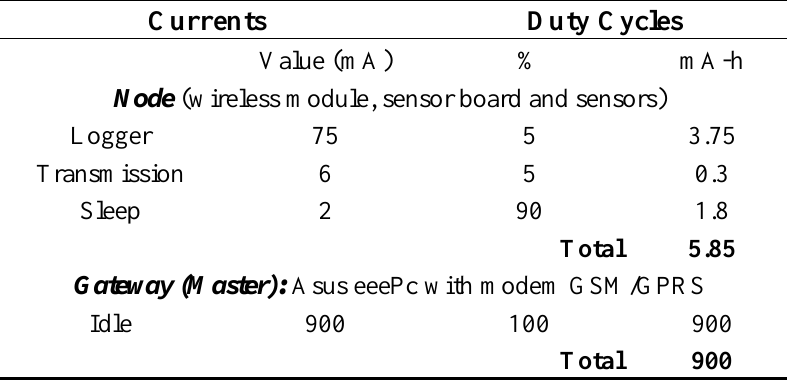
Table 3. Energy consumption for node modules and gateway/master module. The table reports the total energy consumed in different duty